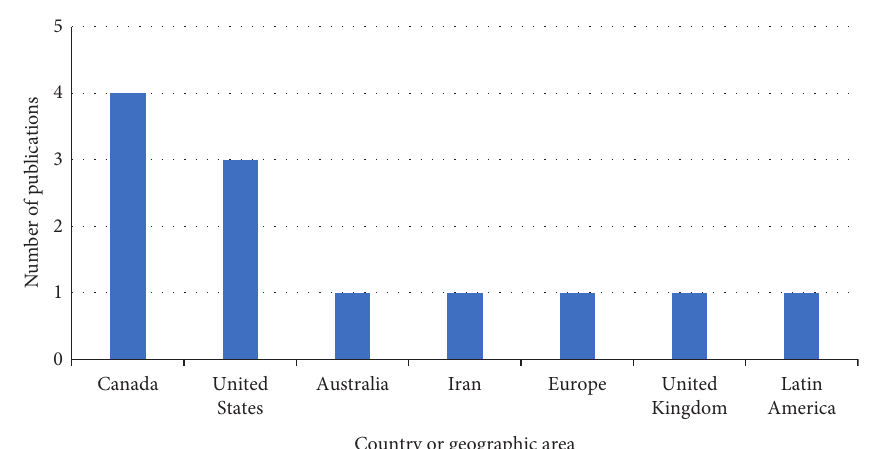
Figure 2: Number of publications by country or geographic